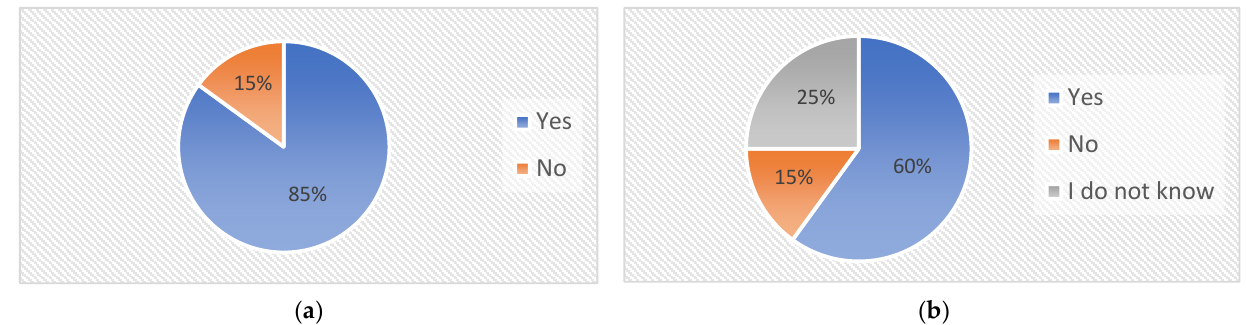
Figure 1. Students ’ answers to questions: ( a ) “ If the study was full-time, would you ask the teacher for help with programming rather than through online study? ” ( b ) “ Would an additional IoT module to Nucleo-64 help you, with which the teacher would monitor the status of your microcontroller, so that he could identify possible problems in solving tasks? ” .